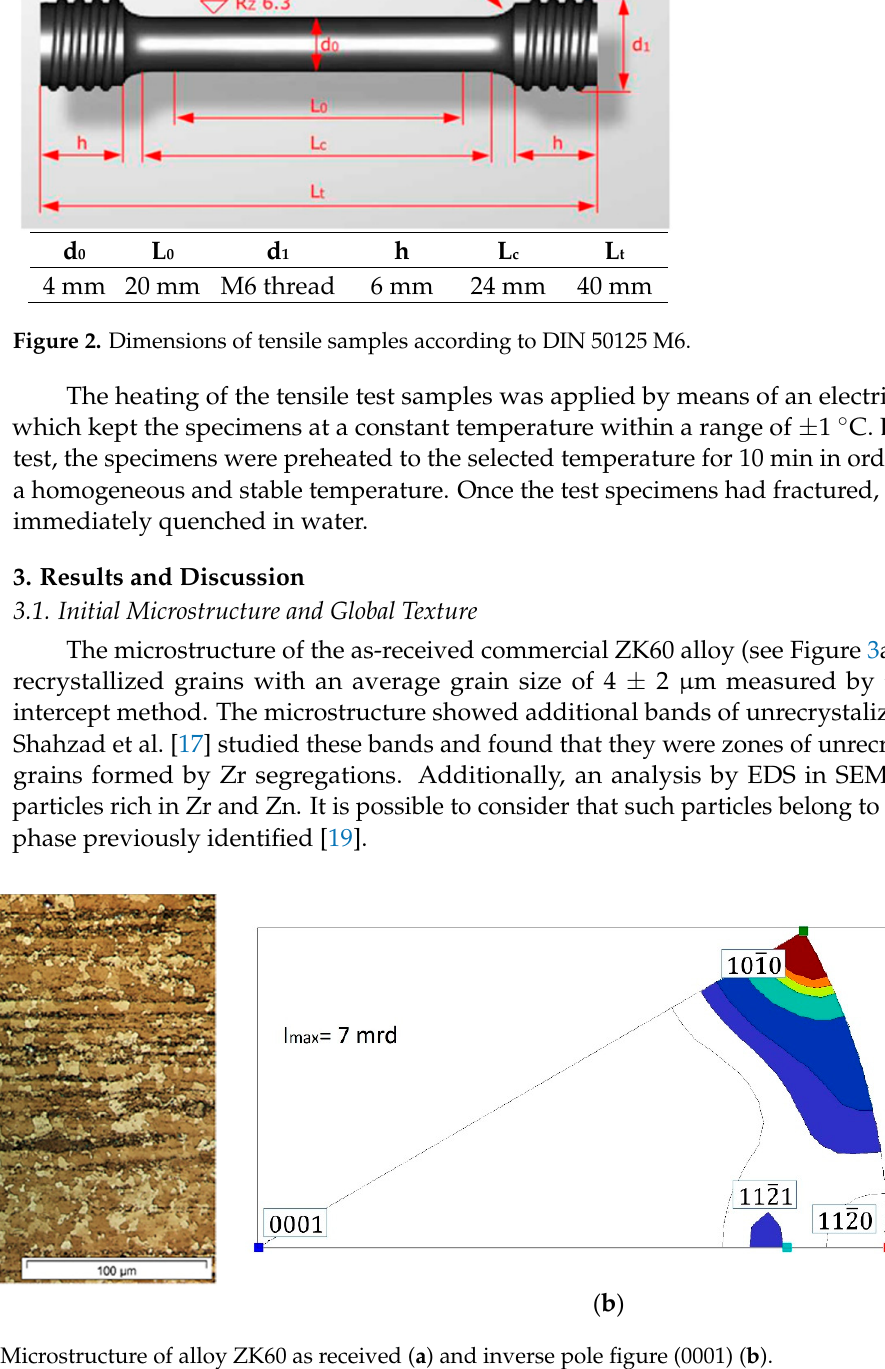
Figure 1. Location and orientation of samples for microstructural characterization and tensile tests.